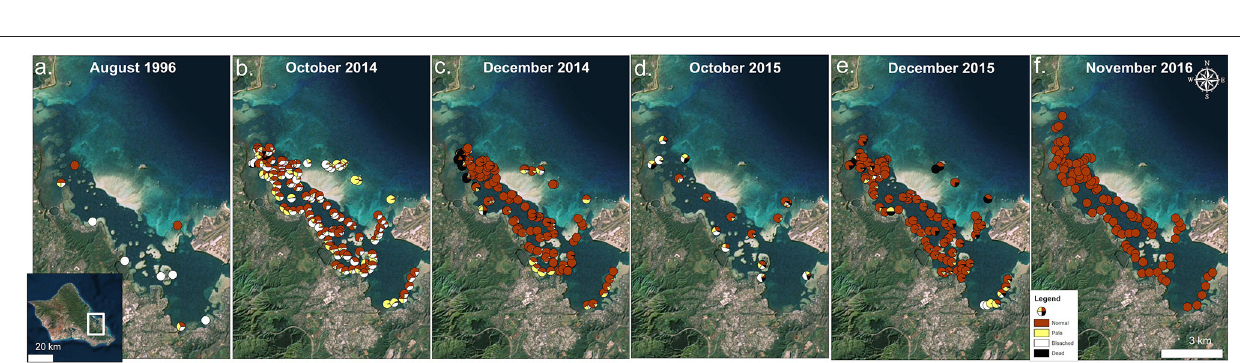
FIGURE 2 | Mean mid-day temperature ( ◦ C) by location in K¯ane‘ohe Bay, HI during the 2015 bleaching event collected at 15min intervals with Onset ProV2 HOBO Temperature loggers.